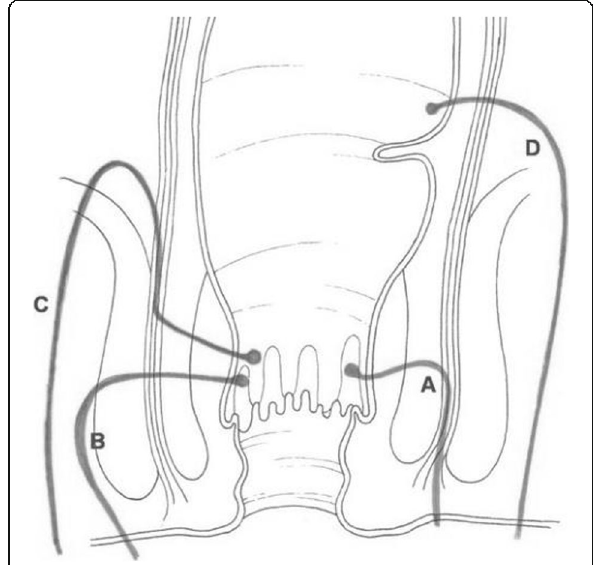
Fig. 1 Different types of perianal fistula according to Parks